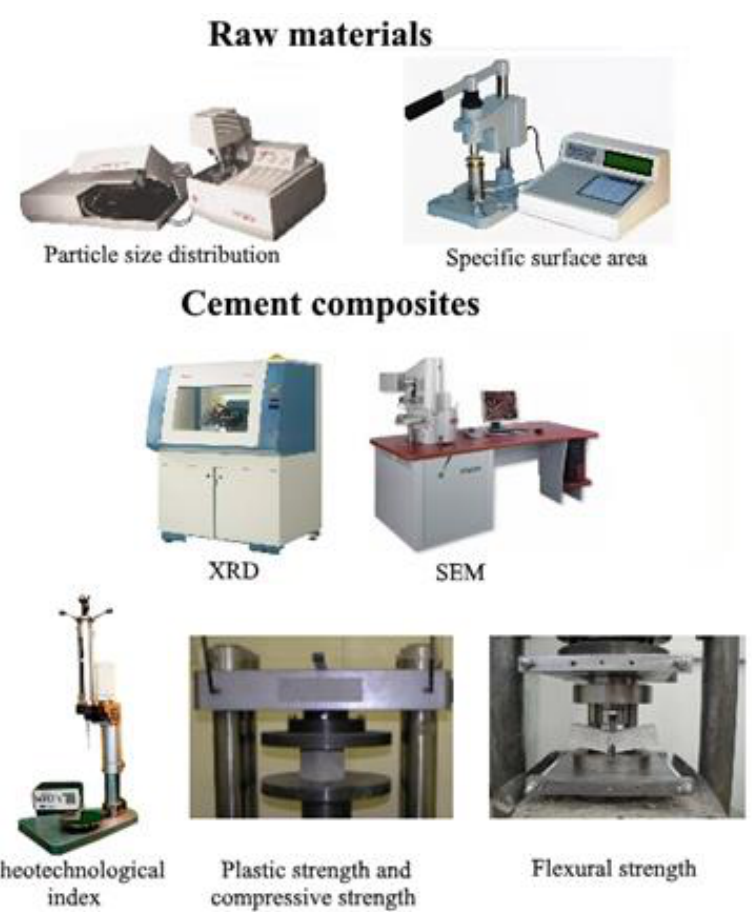
Figure 3. Flowchart of the laboratory equipment.